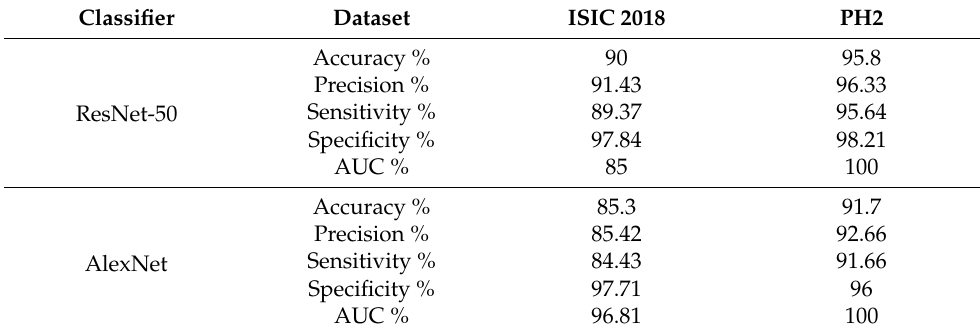
Table 6. The performance of the ResNet-50 and AlexNet algorithms on the ISIC 2018 and PH2